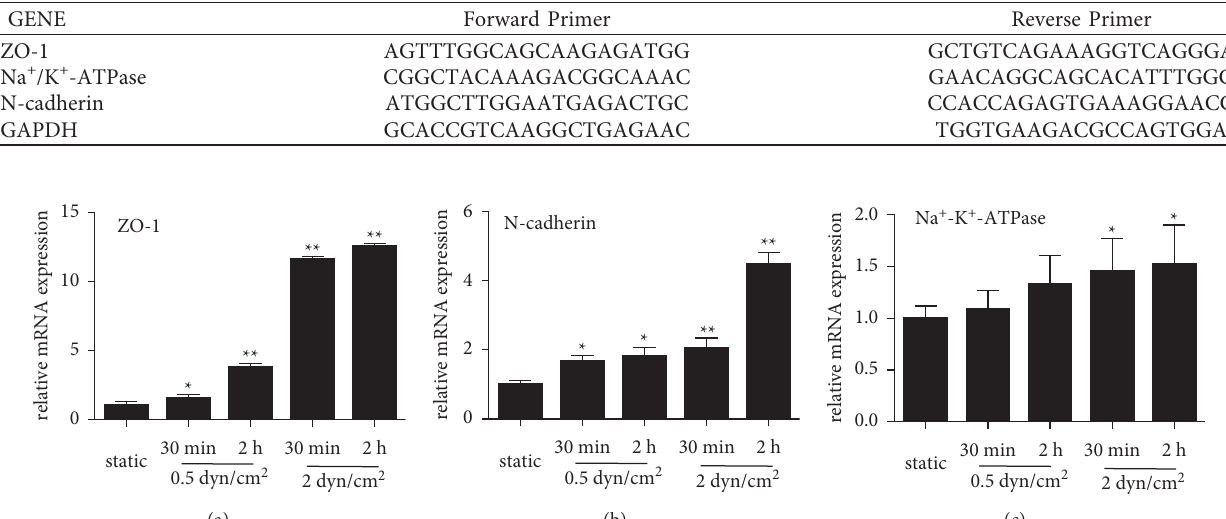
Table 1: The primers used for real-time